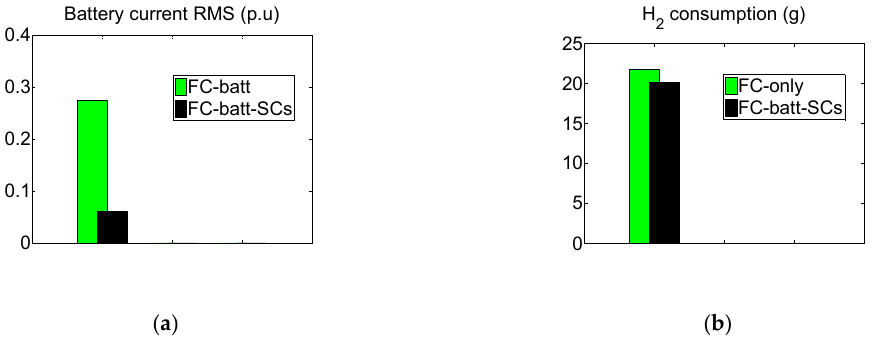
Figure 12. Performance index: ( a ) H2 consumptions of the FC-BAT-based vehicle (green color) and FC-BAT-SC-based vehicle (black color); ( b ) battery current (root mean square (RMS) value) of the FC- based vehicle without any secondary source (green color) and FC-BAT-SC-based vehicle (black color).